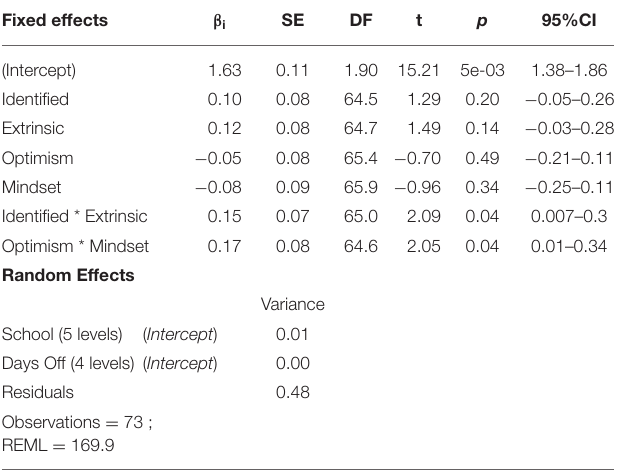
TABLE 4 | Linear mixed effects model of time spent on math homework in N = 73 middle school students tested during the COVID-19 lockdown with schools open.